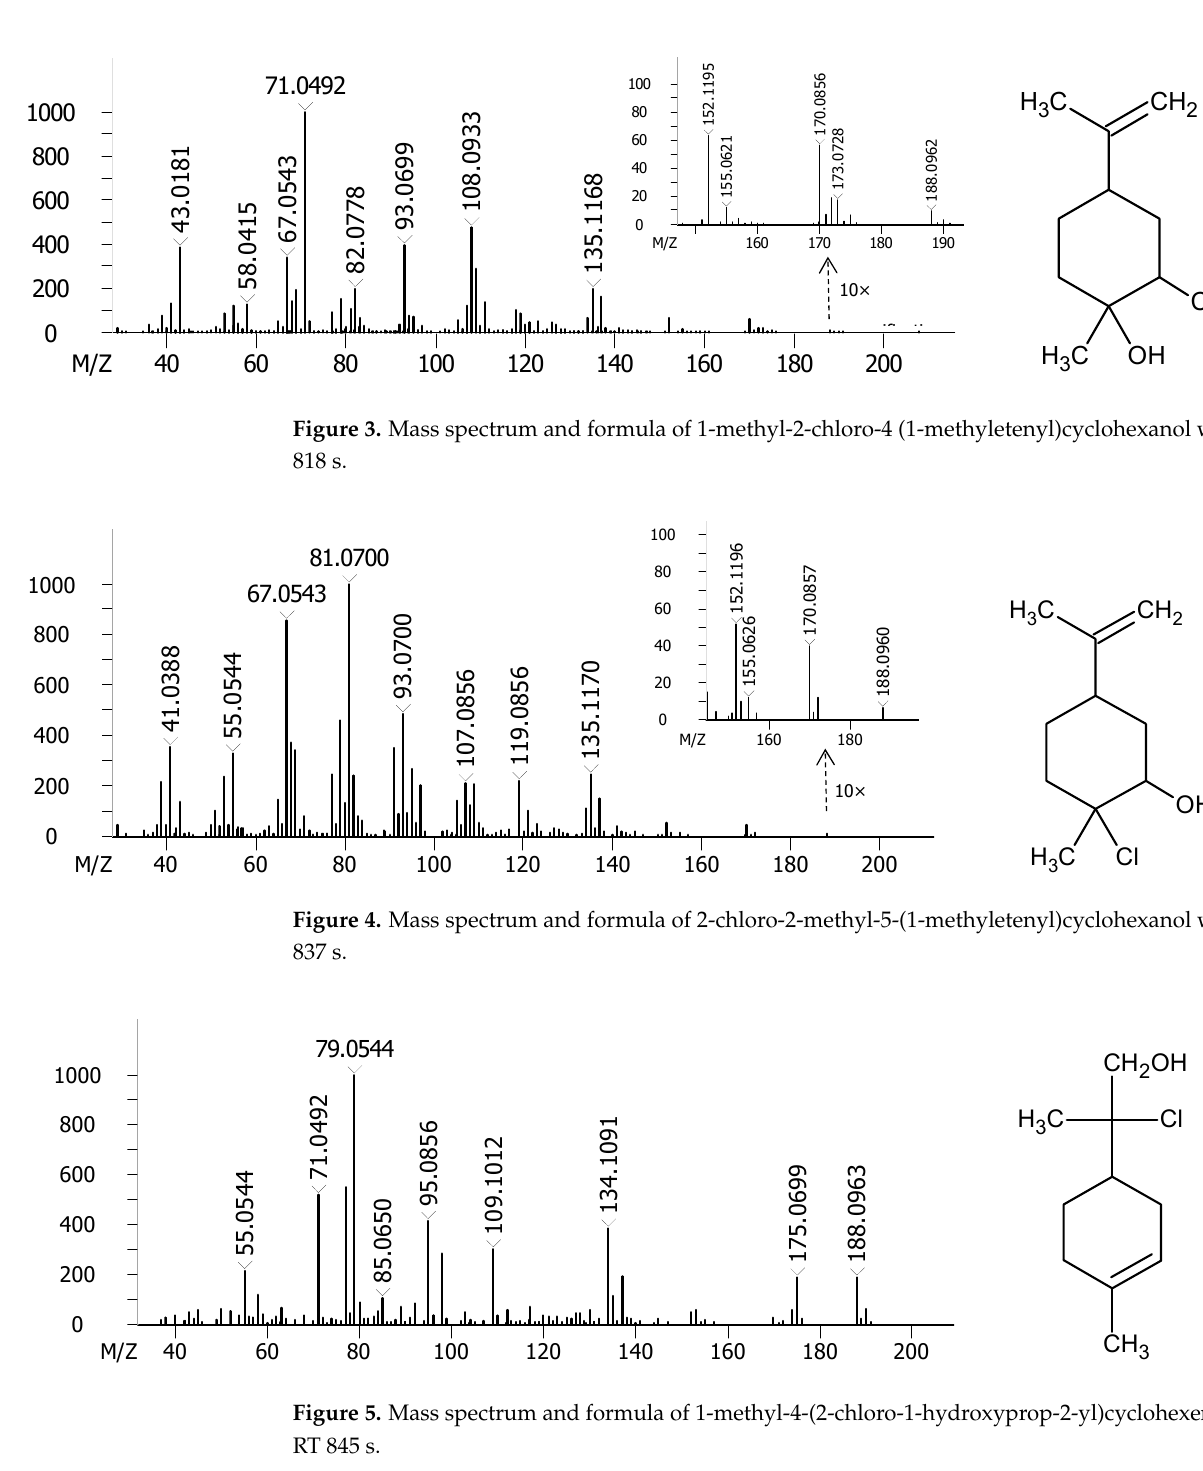
Figure 6. Mass spectrum and formula of 1-methyl-4-(1-chloro-2-hydroxyprop-2-yl)cyclohexene with RT 848s.